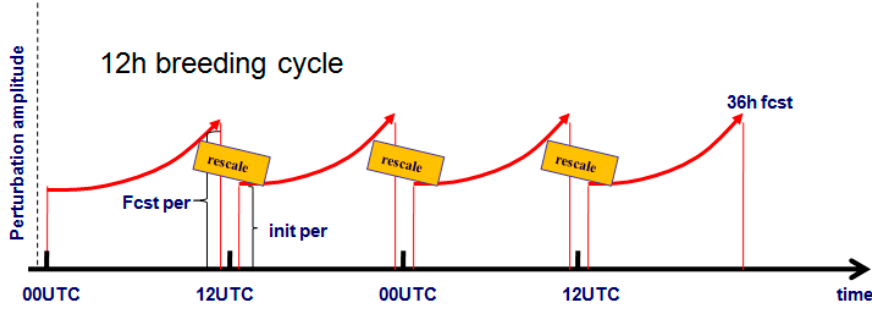
Figure 2 . Flow chart of the REPS Breeding cycle. Figure 2. Flow chart of the REPS Breeding